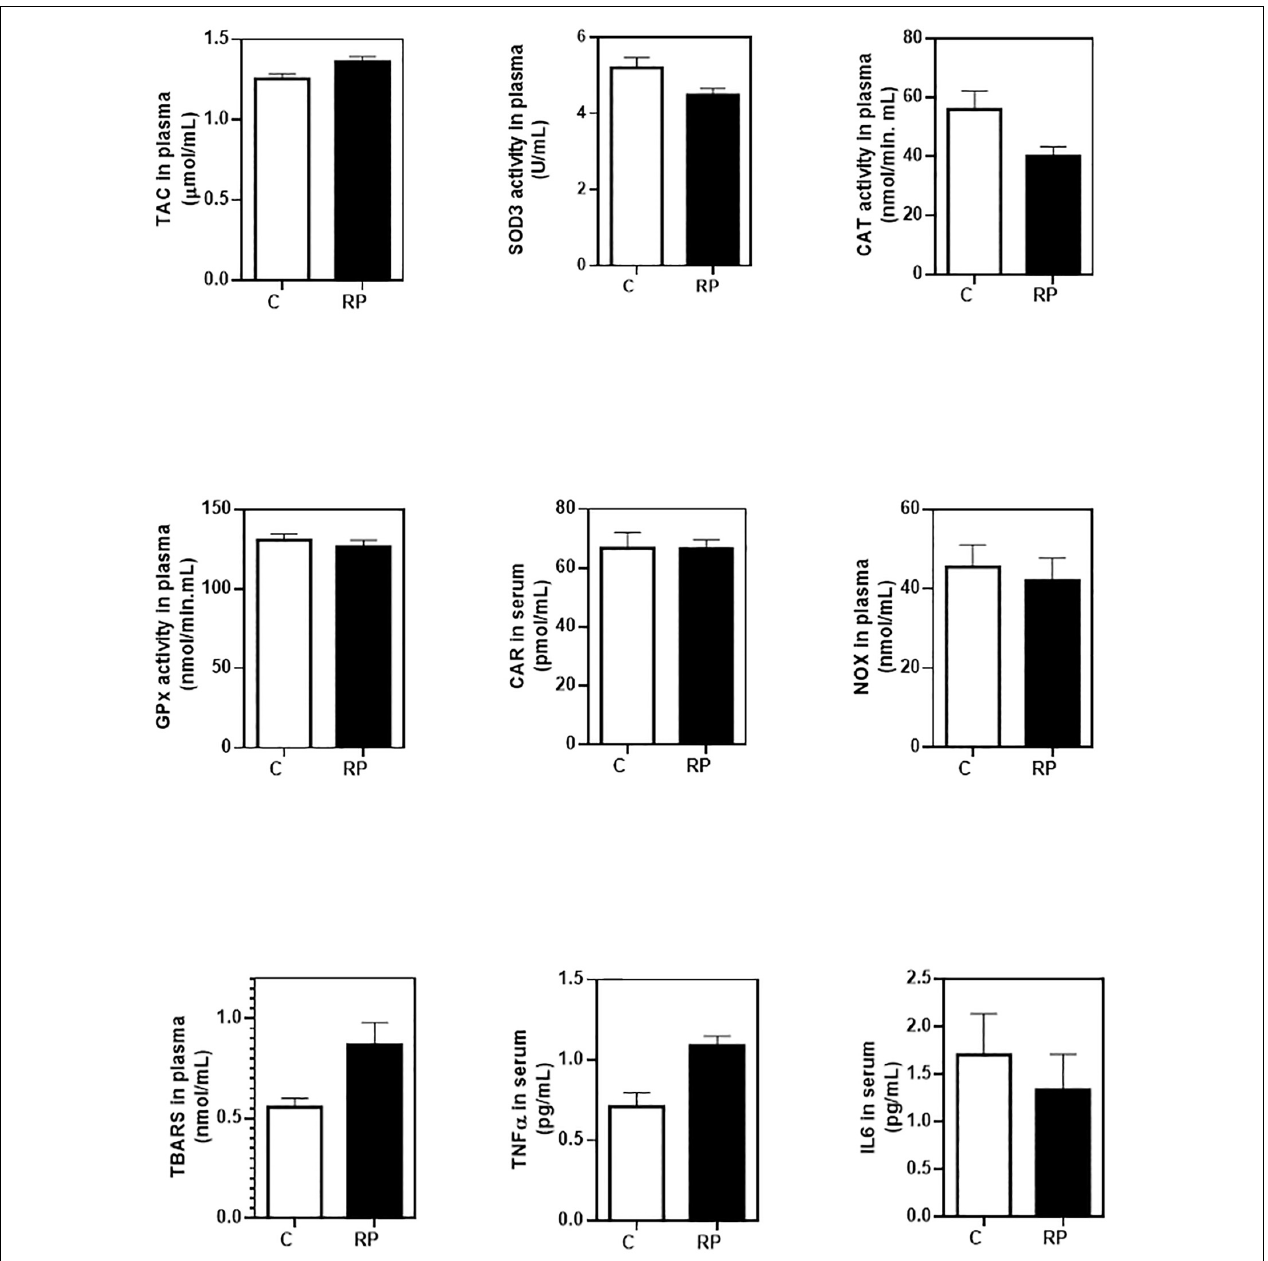
FIGURE 4 | Baseline concentrations of antioxidant, oxidant and inflammatory markers in blood of controls and RP patients. Peripheral redox status was determined by measuring total antioxidant capacity (TAC), extracellular superoxide dismutase (SOD3), catalase (CAT) and glutathione peroxidase (GPx) activities, lipid peroxidation (TBARS formation), nitric oxide metabolites (NOX), and protein carbonyl adduct (CAR) content with commercial kits. Serum cytokines were measured by commercial enzyme immunoassay kits. All data were plotted in bar graph with standard error bars. C, control subjects; RP, patients with retinitis pigmentosa; TBARS, thiobarbituric acid reactive substances; NOX, nitrites and